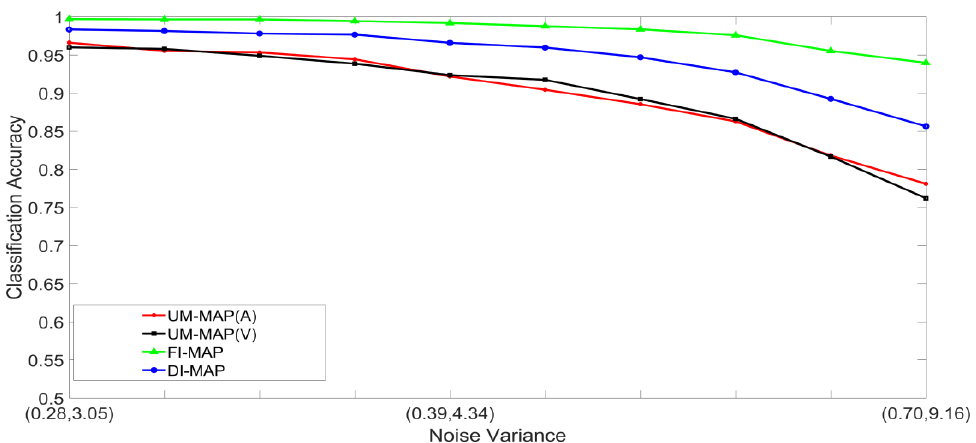
Figure 11. Classification accuracy, as a function of noise, and 𝛼 = 0.9 in both stimuli, for the MAP-based classification systems.